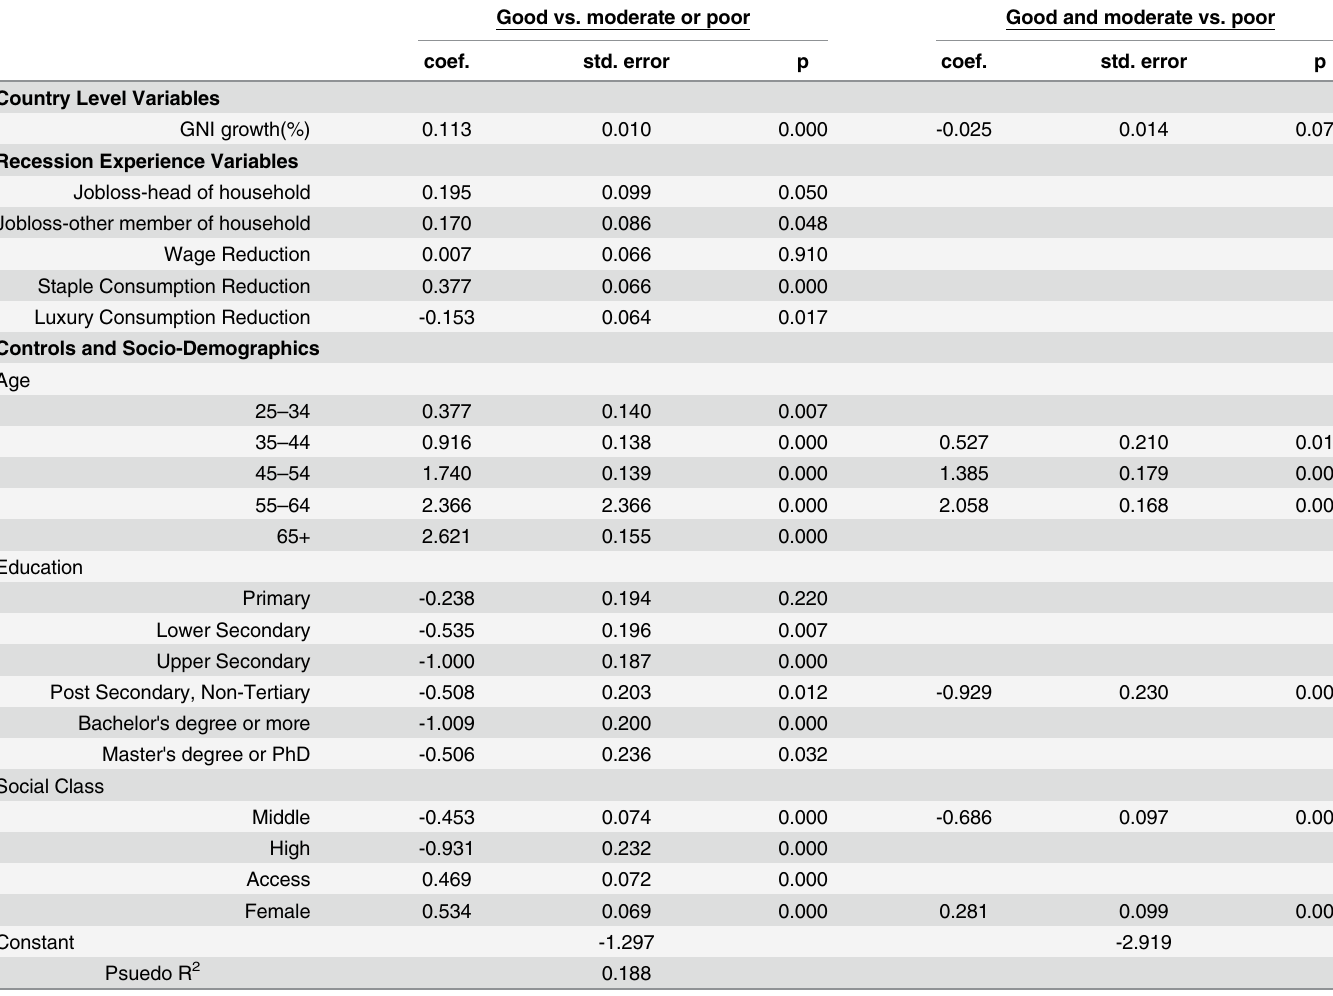
Table 7. Partial Proportional Odds Model for Self-Rated Health, second GNI per capita quartile ($5550-$10,100). Good vs. moderate or